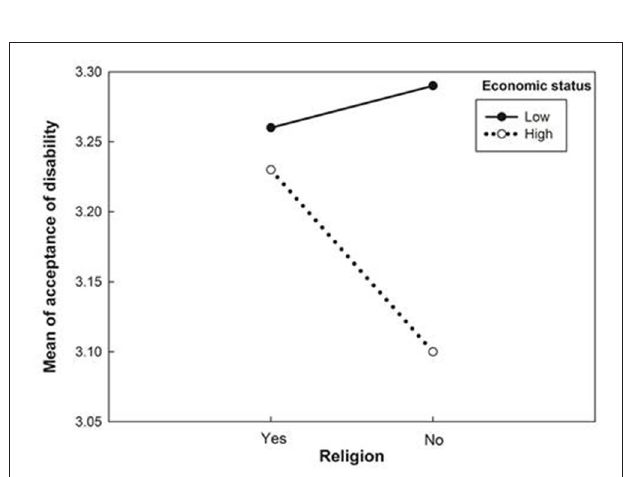
FIGURE 2 | Religion effects of economic status on acceptance of